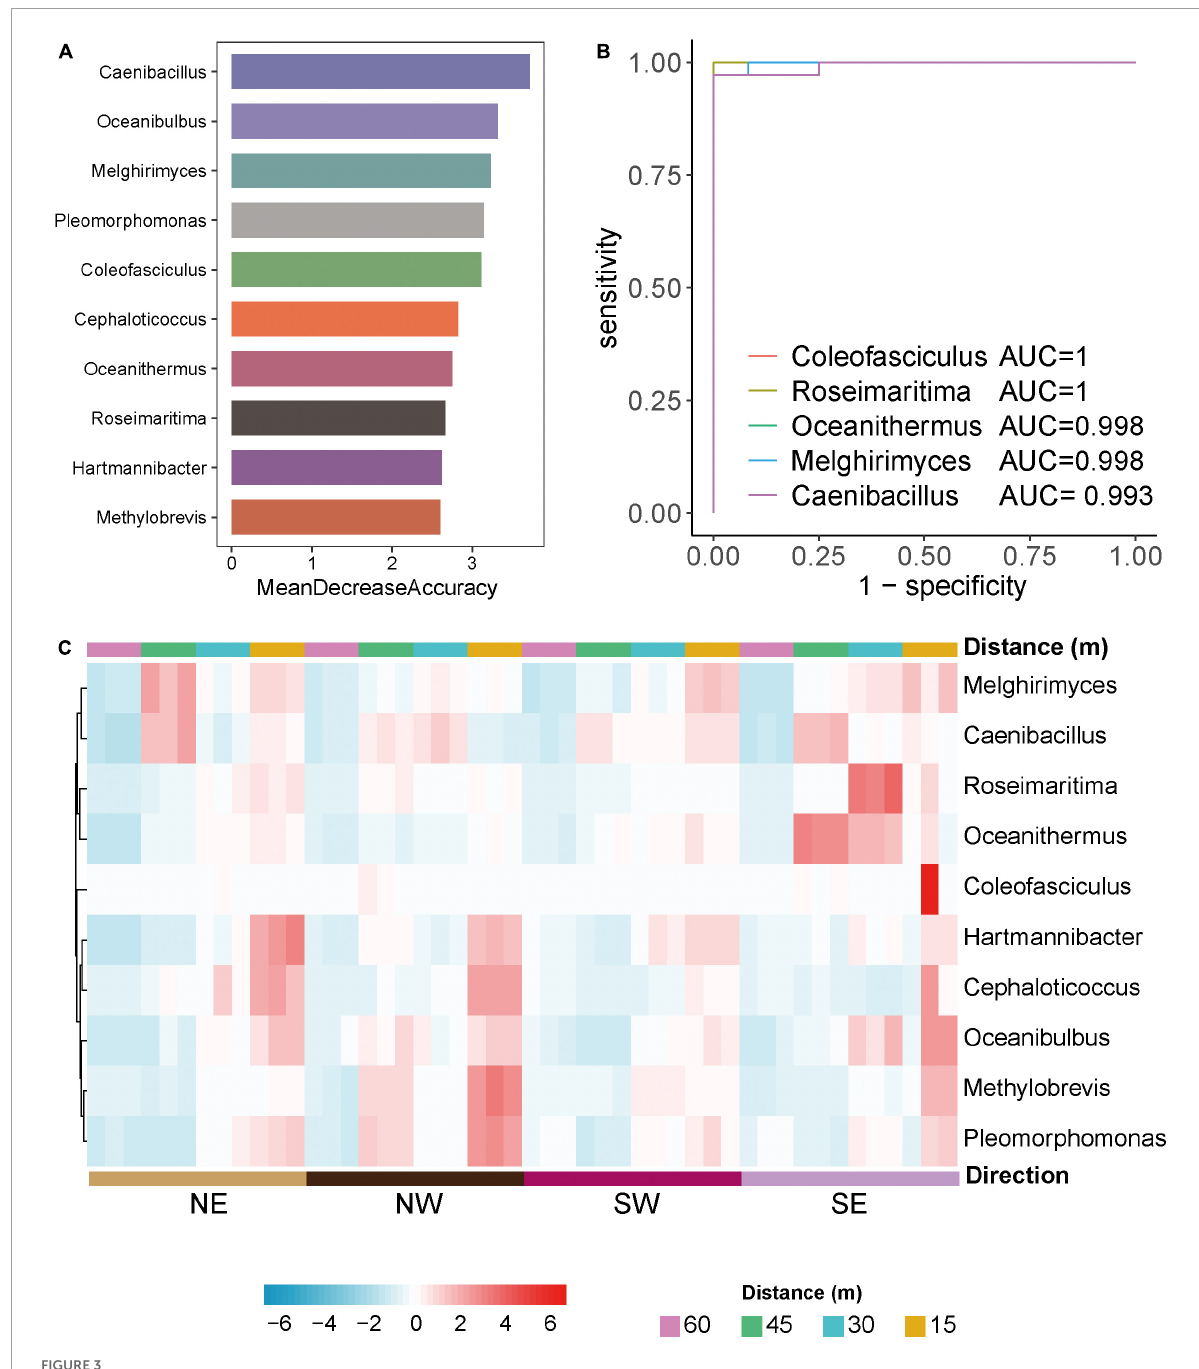
FIGURE3 Differential microorganisms in Salt Lake soil. (A) The 10 most discriminant genera in the models classifying different distances of bacterial microorganisms at the genus level based on the random forest method. The bar lengths indicate the importance of the variable. (B) Evaluation of predictive grouping ability of soil microbiota markers based on receiver operating characteristic (ROC) curve analysis. Draw the curve with sensitivity as the ordinate. The closer the ROC curve is to the upper left corner, the higher the accuracy of the test. If the area under the ROC curve (AUC) value is 1.0, it reflects the perfect distinction between the two groups, and there is no prediction error. Higher accuracy when AUC is above 0.9. (C) Heatmaps of the 10 most discriminant genera at different distances (15, 30, 45, 60 m) and directions (NE, NW, SW, SE) in the model